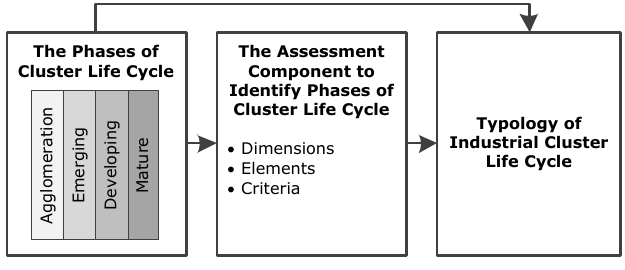
Figure 1. A conceptual model to identify phases of industrial cluster life cycle